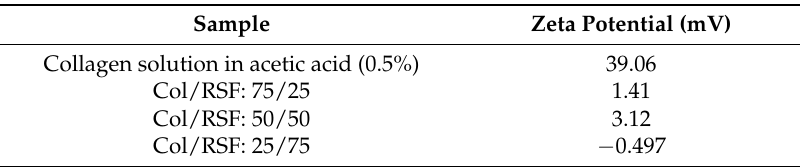
Table 1. ζ potential of collagen/RSF blends. Sample Zeta Potential (mV)